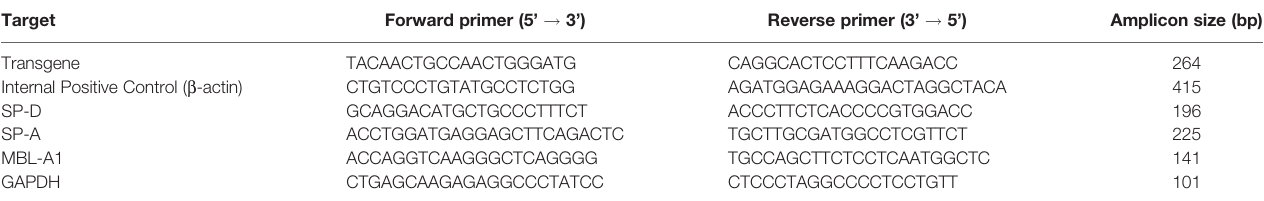
TABLE 1 | Details of murine